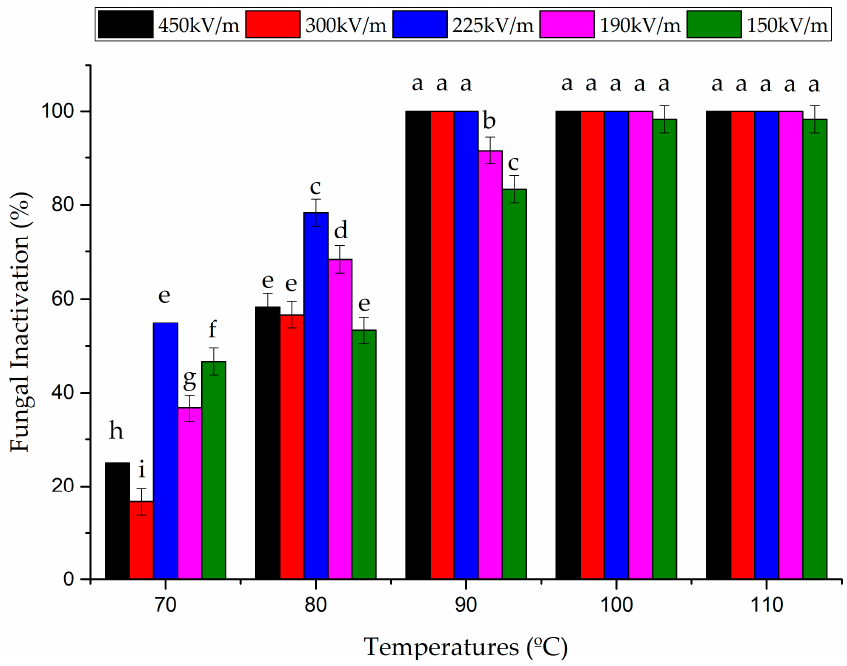
Figure 7. The relative electric field intensity and temperature on fungal growth. Average ± standard deviation from three replicate experiments. Different letters in the same column are considered significantly different according to Duncan’s multiple comparison test ( p ≤ 0.05).